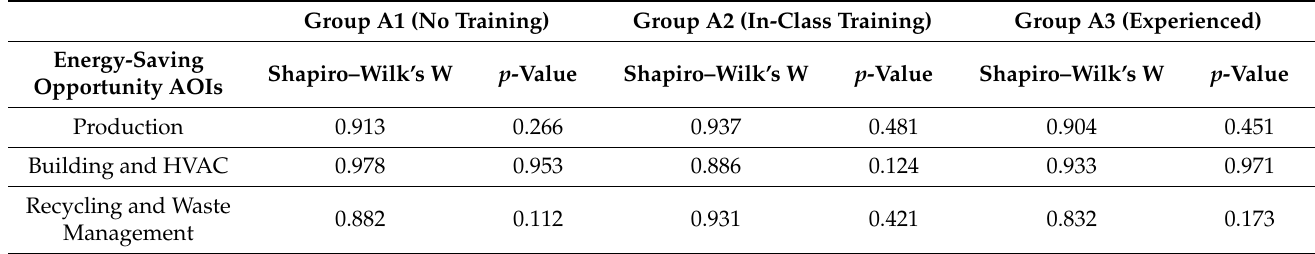
Table 5. Normality results for groups participated in the experiment.